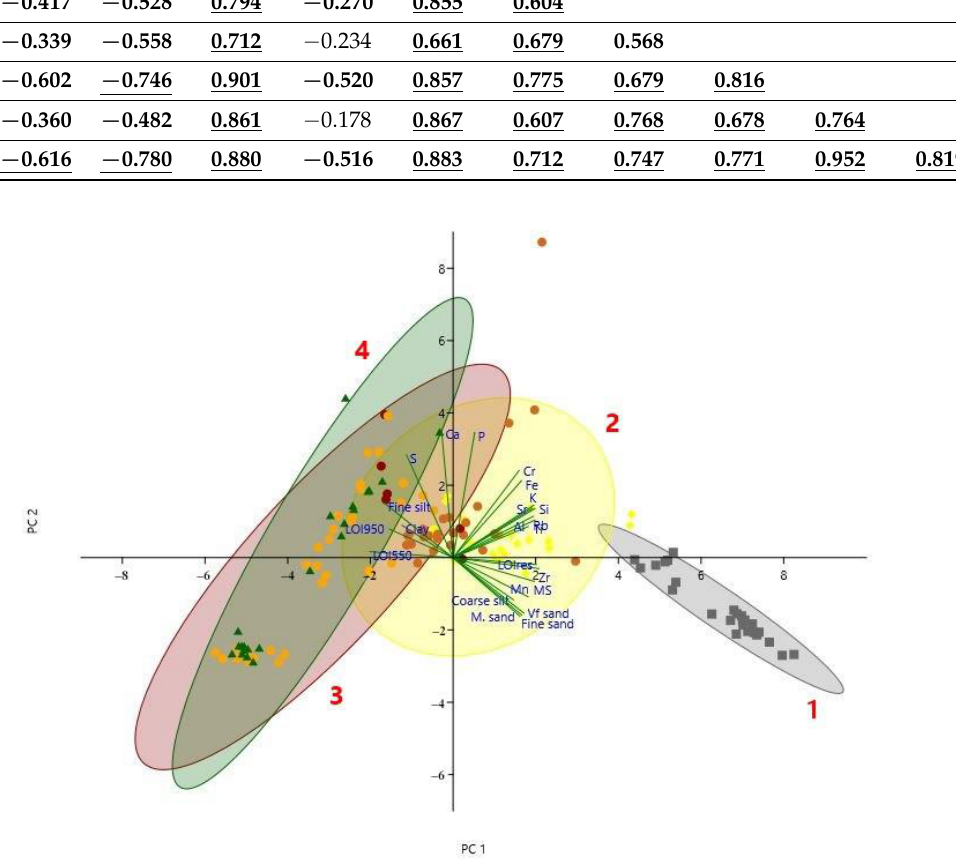
Figure 9. Principal components analysis (PCA) biplot of selected environmental variables and samples with Troels-Smith [35] categories (1. laminated lacustrine mud, 2. calcareous pelitic peat, 3. herbaceous peat, 4. moss peat).